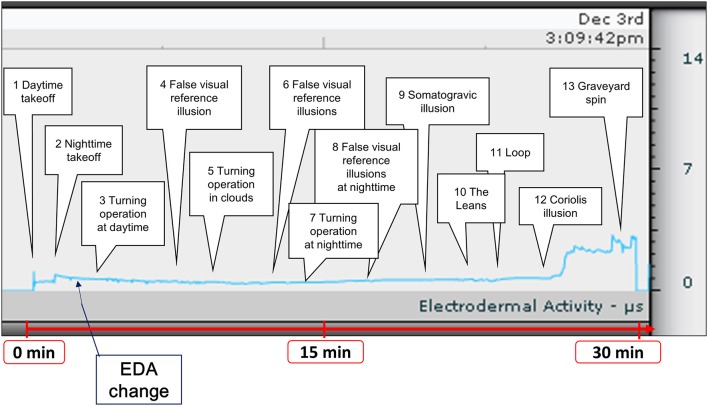
Time course of spatial disorientation training and a representative example of EDA measurement. Participants were exposed to spatial disorientation training, including a visual illusion, vestibular illusion, and a combination of the two for ~30 min. We recorded EDA changes during training. EDA, electrodermal activity.